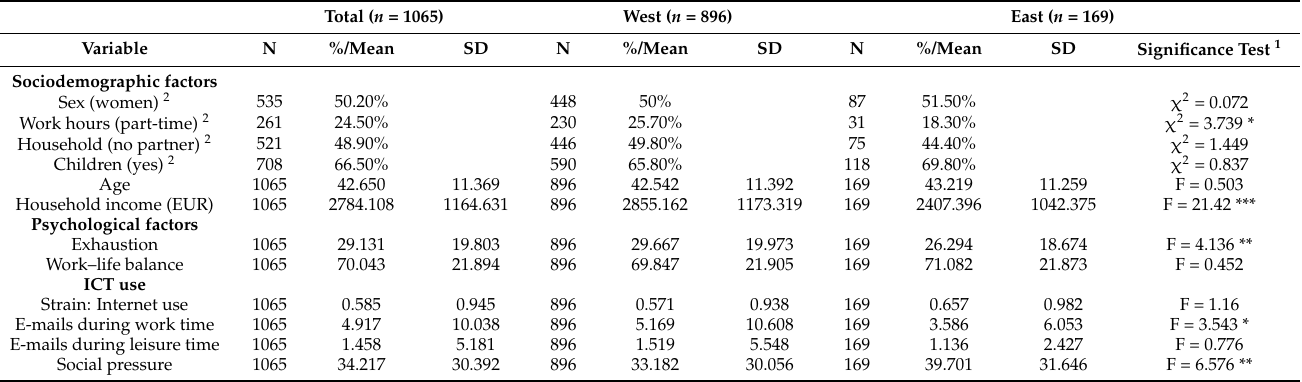
Table 1. Study participants from East and West